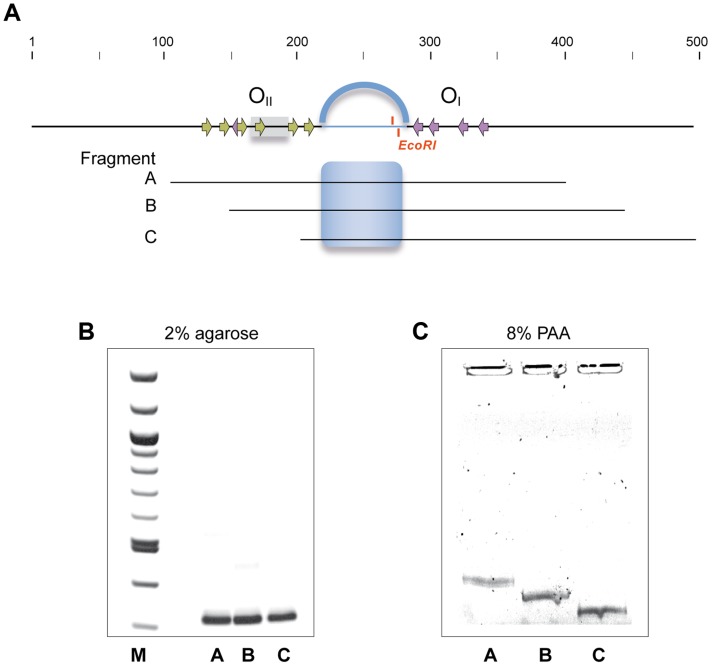
The 75 bp spacer region separating operators OI and OII contains a static bent.
A. Schematic representation of the region encompassing operators OI and OII and the regions corresponding to the DNA fragments amplified by PCR that were subjected to 2% agarose (B) and 8% native PAA (C). Position of the Pc/Pr promoters and the RcoLS20 binding motifs within the operators are indicated with grey rectangles and arrows, respectively. The 75 bp region separating OI and OII is shown as an interrupted line and the position of the unique EcoRI site is given. The predicted curvature in this region is represented by the blue arc above the top line, and by a blue shading in the equivalent region in fragments A–C. Fragments A–C were run on 2% agarose or on 8% native PAA gel followed by ethidium bromide staining.